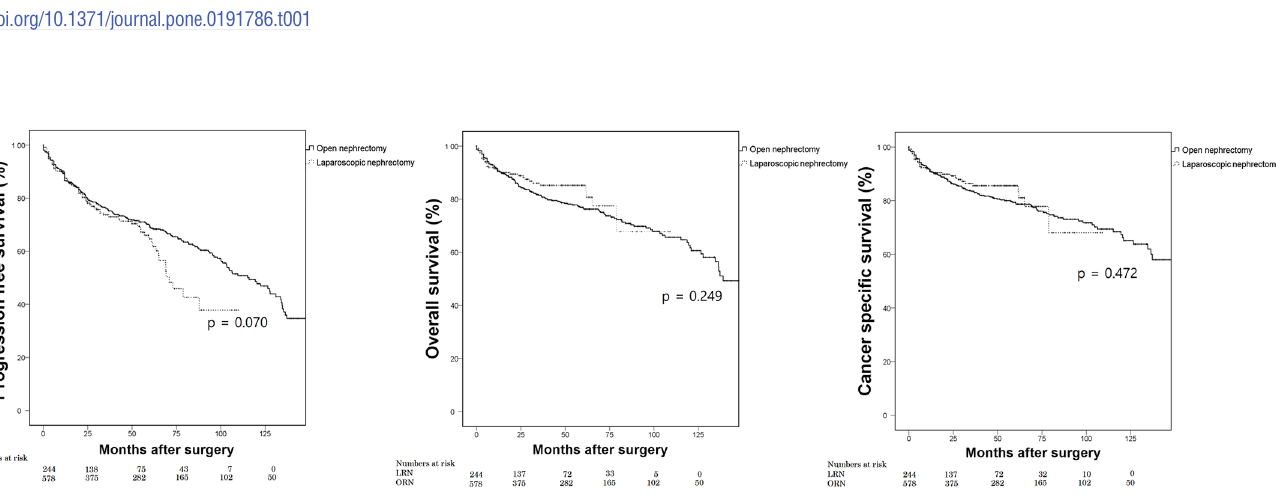
PLOS ONE | https://doi.org/10.1371/journal.pone.0191786 January 24,